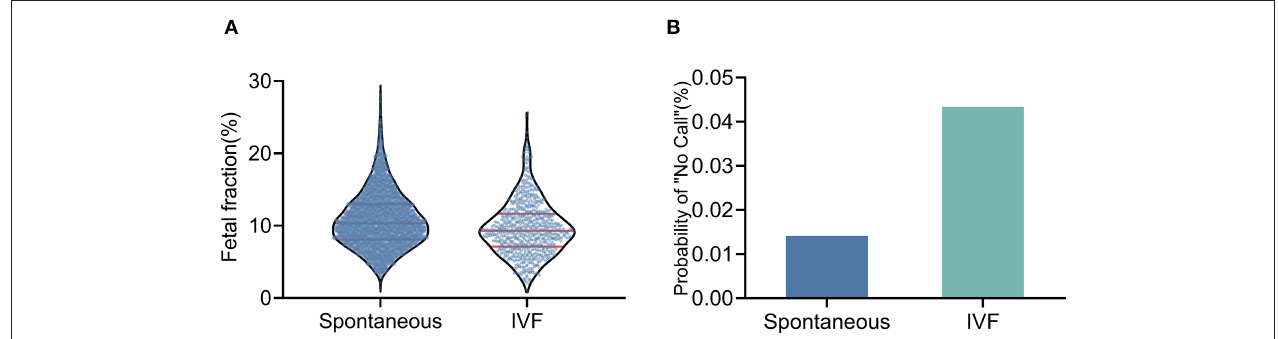
FIGURE 2 | Fetal fraction and test failure rate of NIPT in IVF conceptions and spontaneous conceptions (A) The median fetal fraction was lower in IVF pregnancies. (B) The test failure rate was higher in IVF